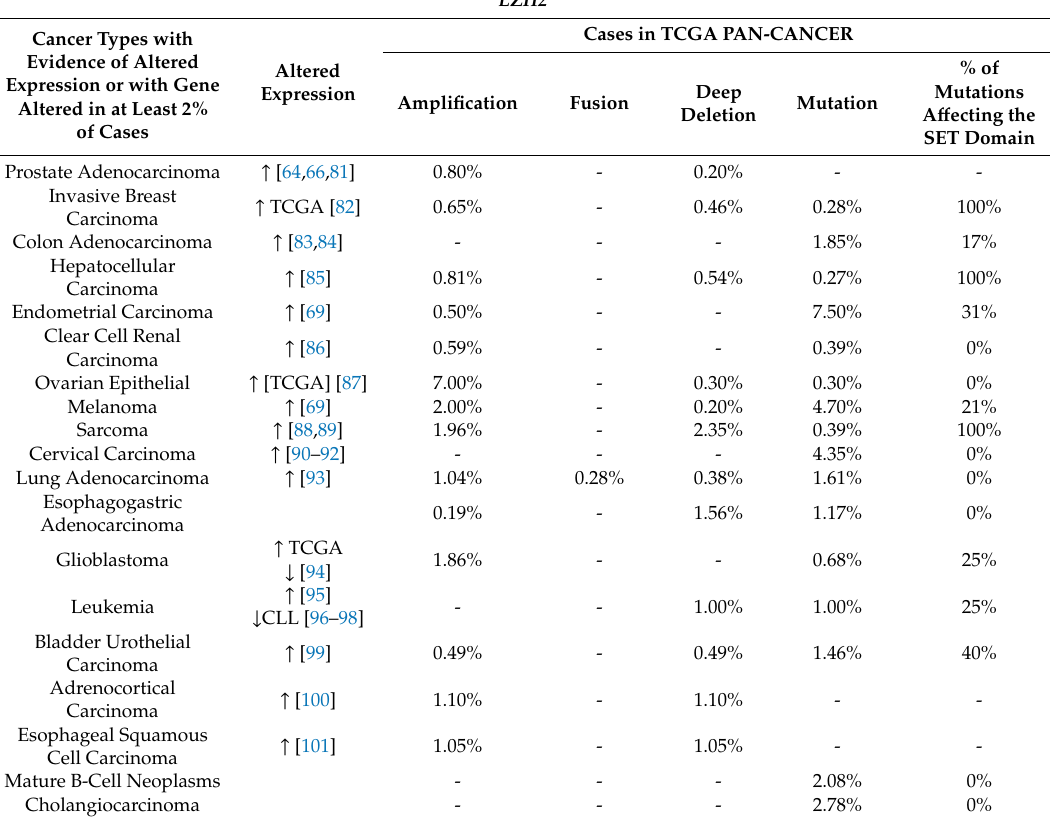
Table 1. EZH2 alterations by cancer type. Data on expression status was collected from studies deposited in Oncomine (http: // www.oncomine.org / ) or in the scientific literature. Data on mutation, gene amplification, and deletion were collected from the TCGA PanCancer dataset using cBioPortal [79,80]. Cancer types with alteration at EZH2 in at least 2% of cases are shown. All mutations within the SET domain or truncating mutations prior to the SET domain were considered to compromise enzymatic